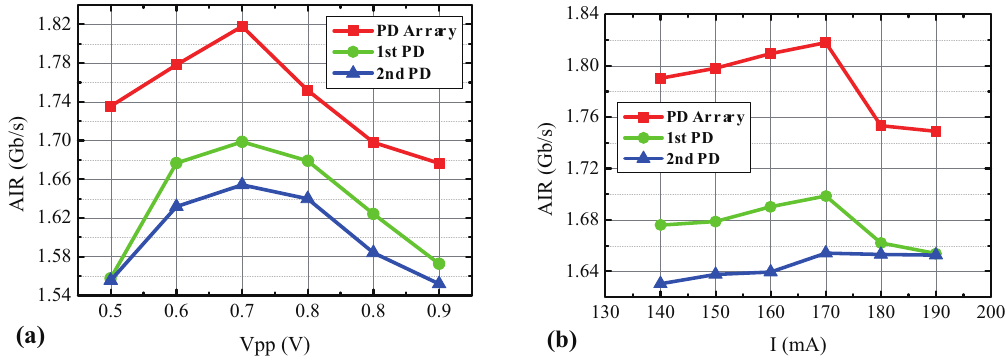
Figure 5. Comparison of the AIR with the PD array and single PD at 1 m under ( a ) different Vpp with 170 mA bias current, and ( b ) LED bias current with 0.7 Vpp.